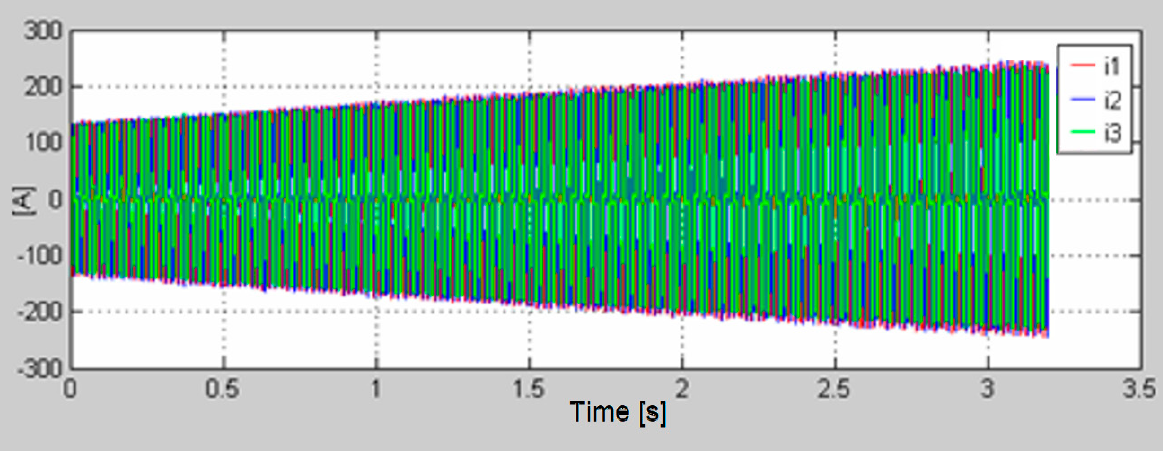
Figure 13. Currents absorbed from the supplying network at the load connection during the start of the driving system.